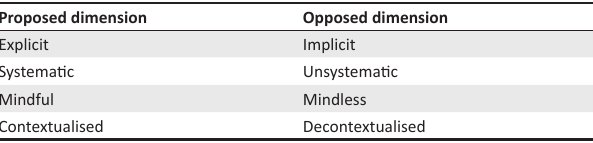
TABLE 1: Four instructional principles of teaching and learning. Proposed